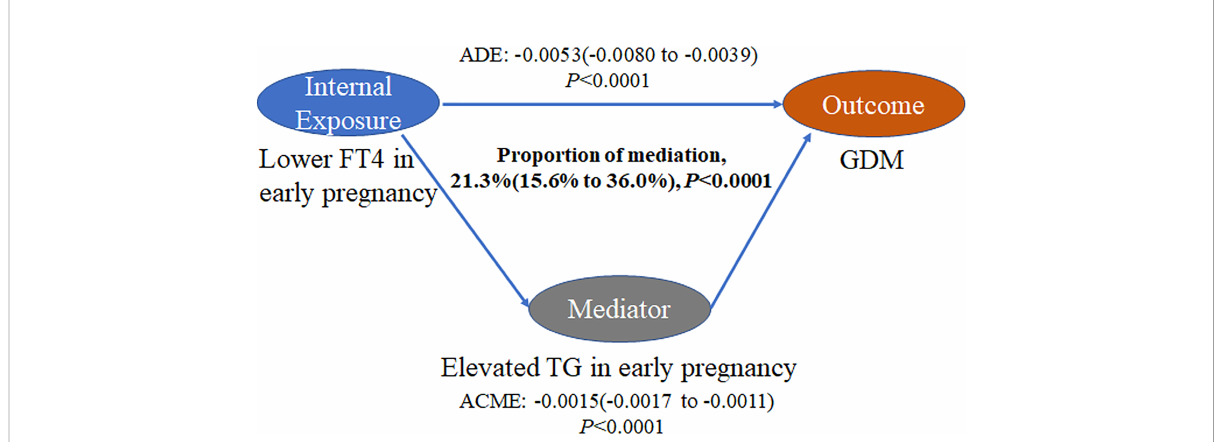
FIGURE 5 Mediation analysis of the association of FT4 levels with GDM by TG levels. The fi gure presented TG as the mediator, the estimate of average mediation effects (ACME), the estimate of the average direct effects (ADE), and the proportion of mediation. The mediation models were adjusted for maternal age, education levels, family history of diabetes, parity and prepregnancy